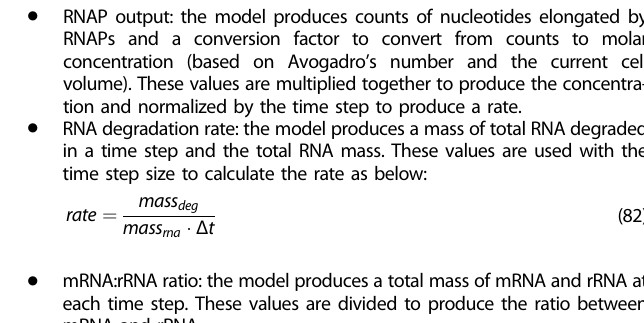
Figure 5 . Panels a, b and c : Literature data (dashed line) comes a linear fi t to data in Bremer et al. 30 . Simulation data for minimal and rich media references (single points) comes from Simulation set 9 (excluding the fi rst 6 generations). Simulation data for the trajectories comes from Simulation set 1 for a, Simulation set 2 for b, and Simulation set 3 for c. Growth rate comes directly from simulation output. RNA/protein mass ratio is determined by the RNA mass divided by protein mass at each time step. A moving average is applied to each cell trajectory data series (multiple generations from a single starting seed) with a window of 200 time points. The mean and standard deviation for the reference points is